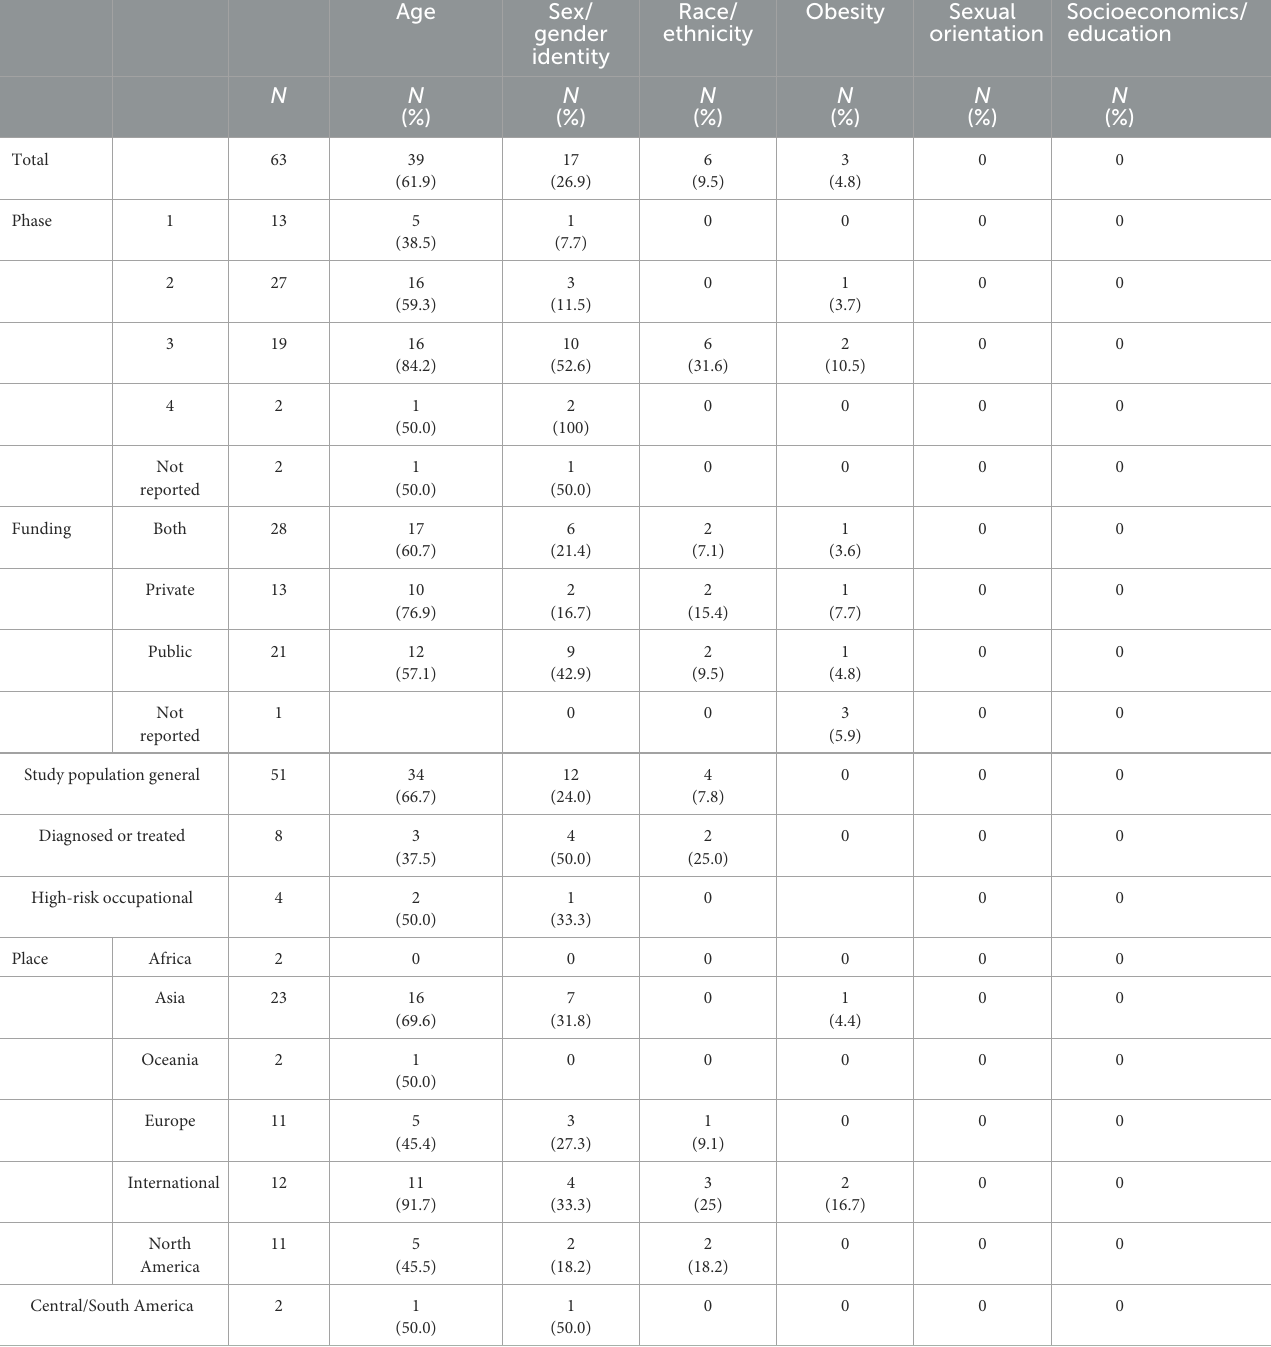
TABLE 3 Report of efficacy results stratified by axes of social inequity according to study